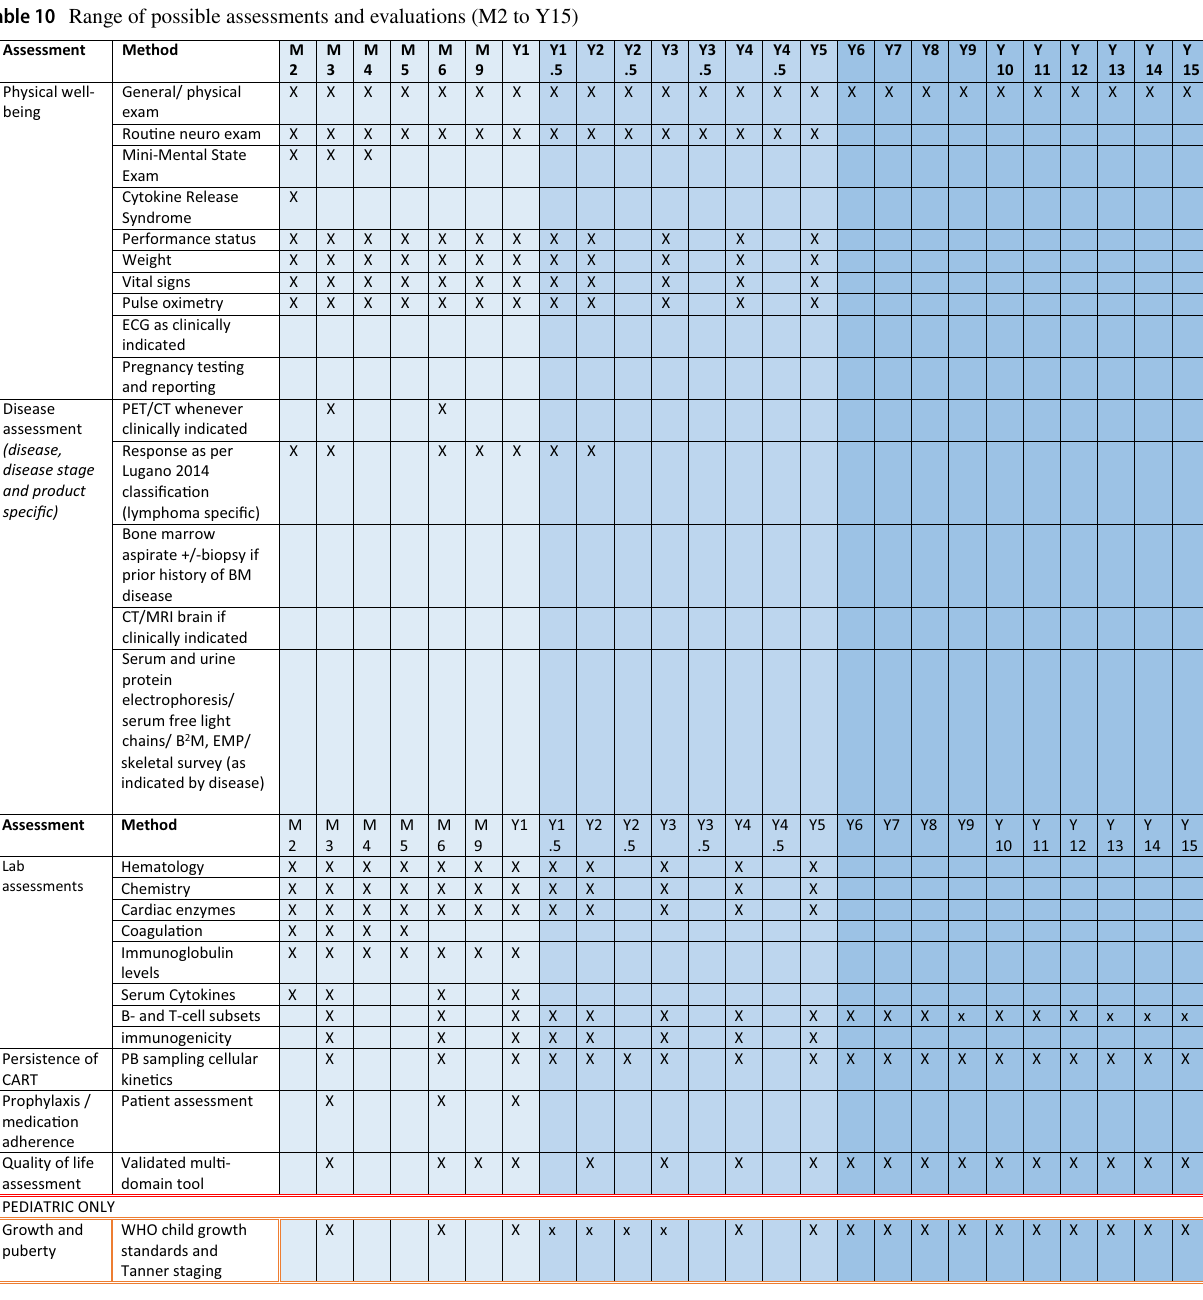
* Grading as per Common Terminology Criteria for Adverse Events, version